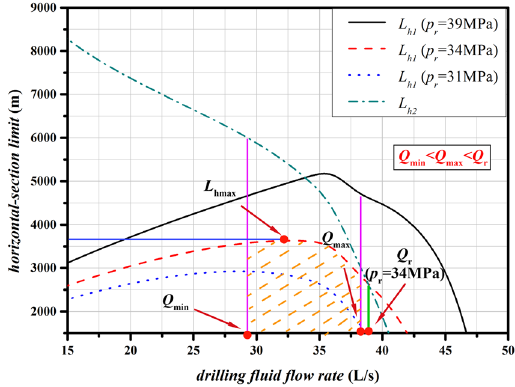
Figure 3. Schematic overview of the situation Q min < Q max < Q r (Case II) and effects of different rated pump pressures on L h1 and L h2